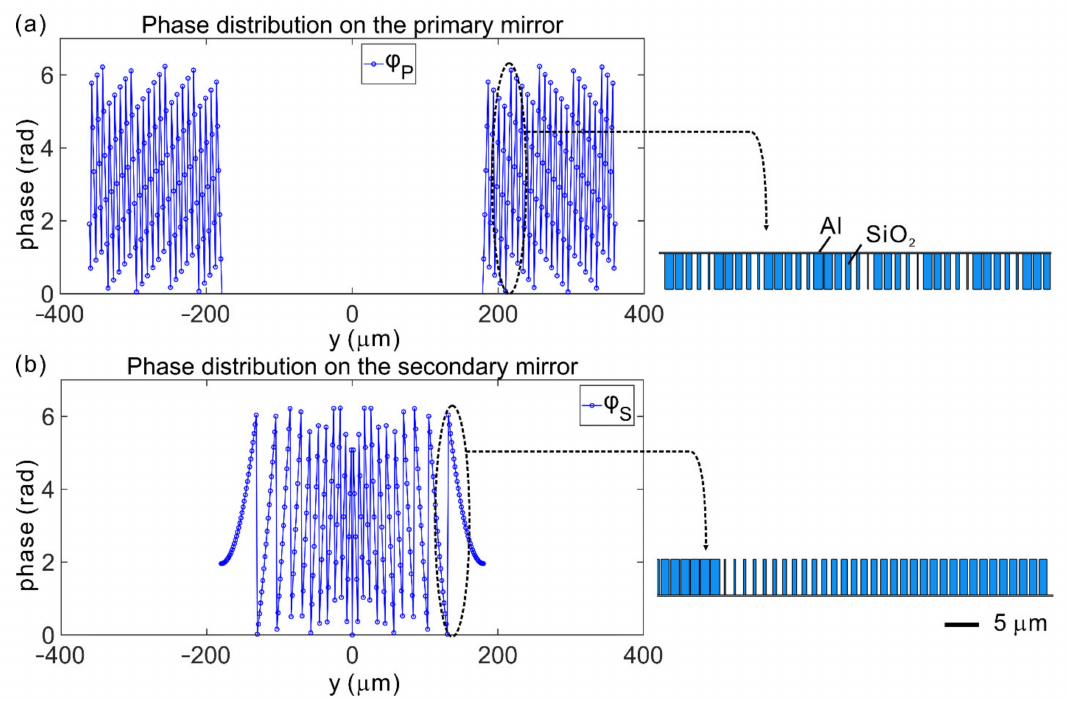
Figure A1. Phase distribution on ( a ) primary and ( b ) secondary mirrors of a typical metasurface Cassegrain